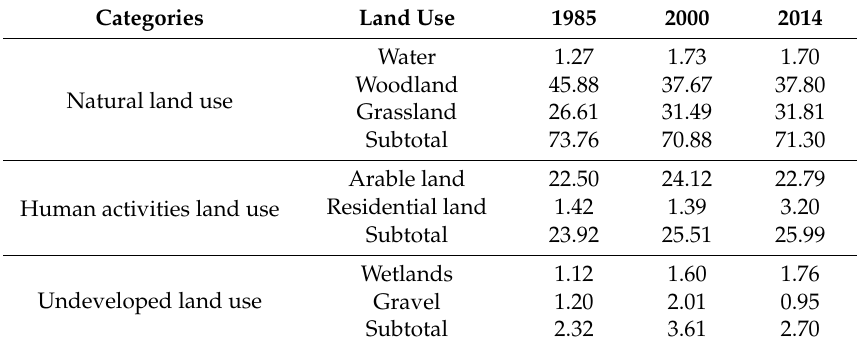
Table 3. Different land use proportions under LUCC scenario